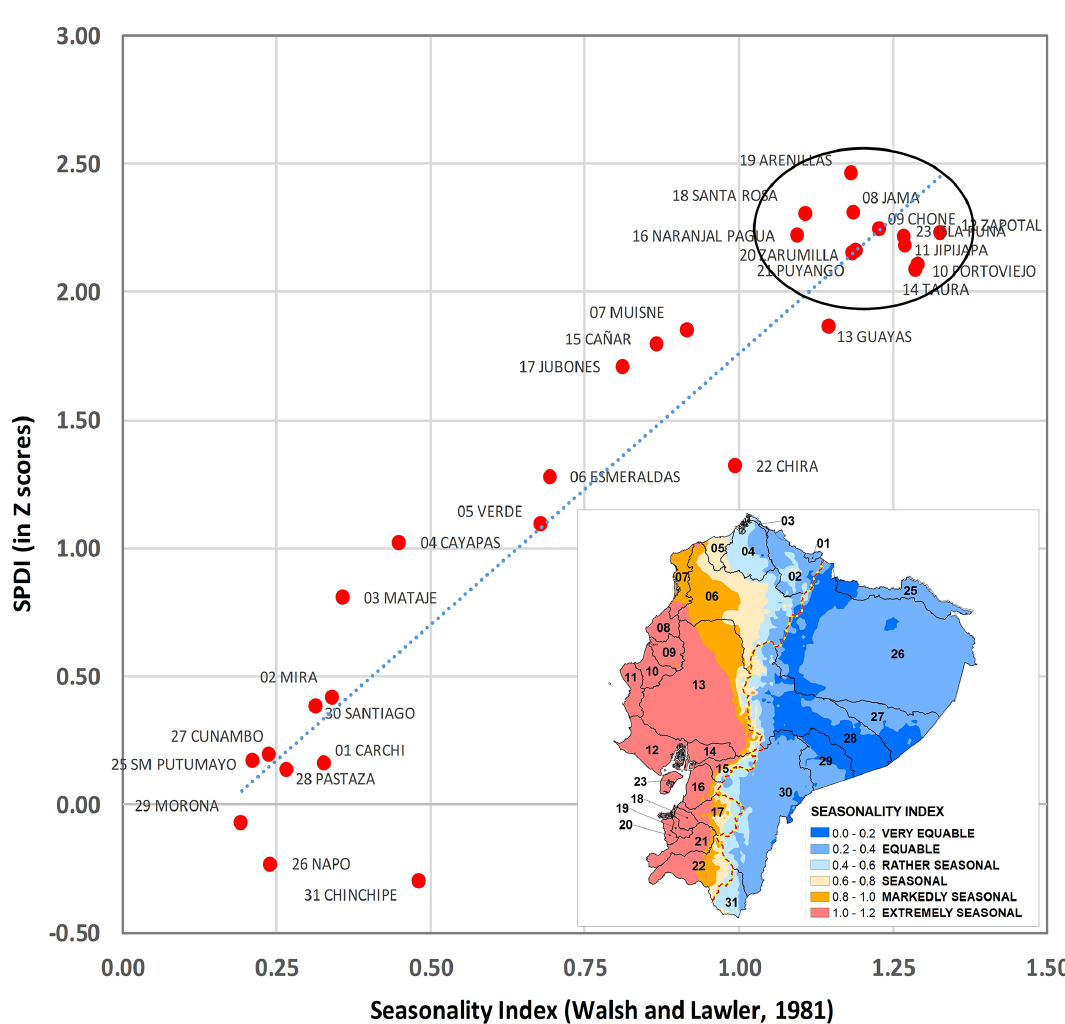
Figure 6. Relationship at a basin level between the Seasonality Index (SI; Walsh and Lawler, 1981) and the mean annual (Year 2) SPDI resulting from the mega-El Niño events EP83 and EP98 and the coastal El Niño COA17. An extremely humid condition (SPDI ≥ 2.0) is reached in basins with the highest SI values (i.e., with rainy seasons concentrated in 3 or fewer months, SI ≥